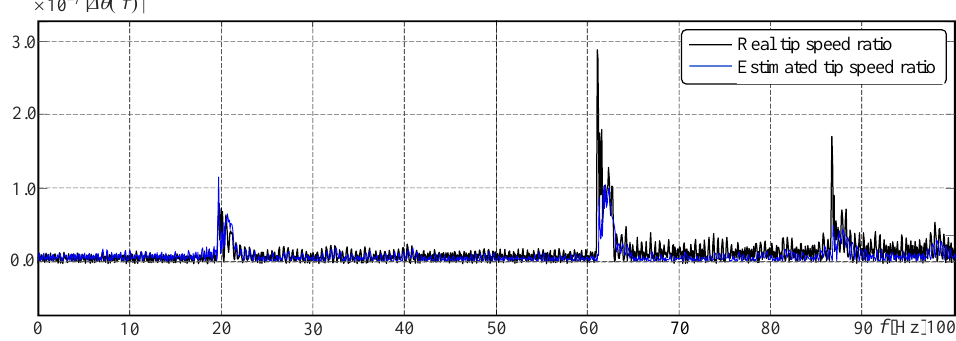
Figure 13. Time series of the twist angle of the slow-speed shaft.